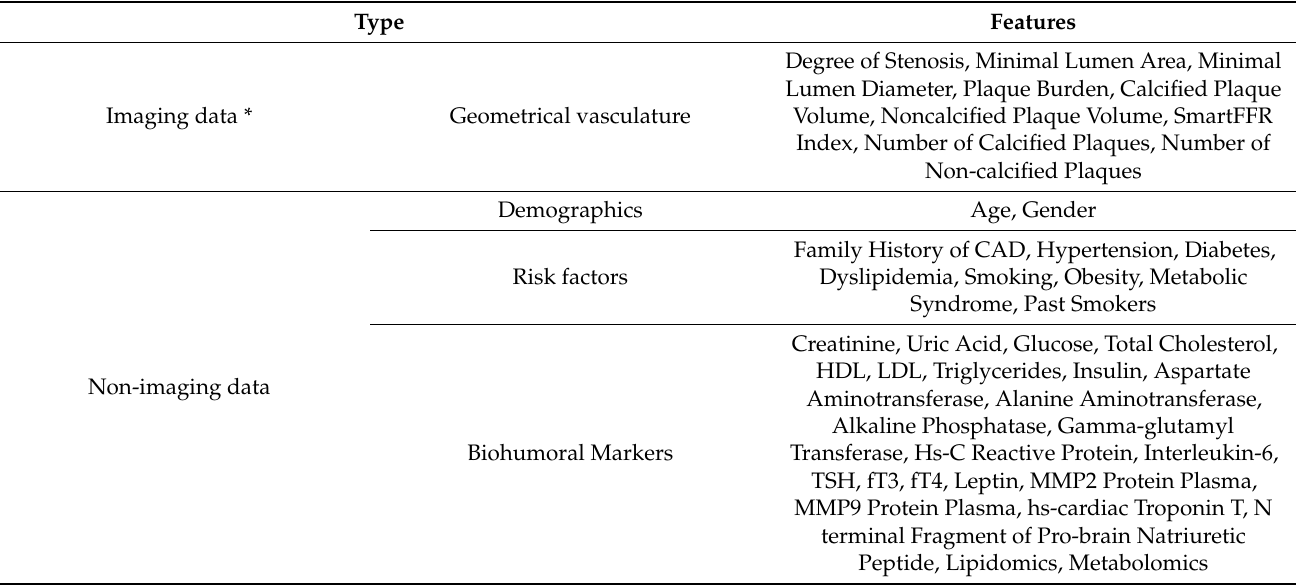
Table 1. Imaging and non-imaging data utilized. * Imaging data from